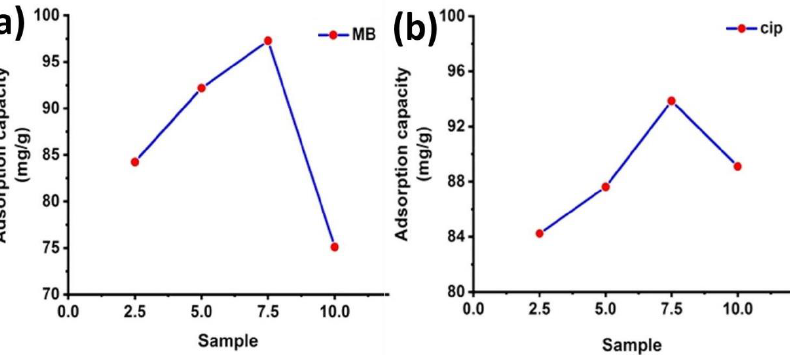
Figure 4. Plot of impregnation ratio vs. adsorption capacity of MB ( a ) and adsorption capacity of ciprofloxacin ( b ).